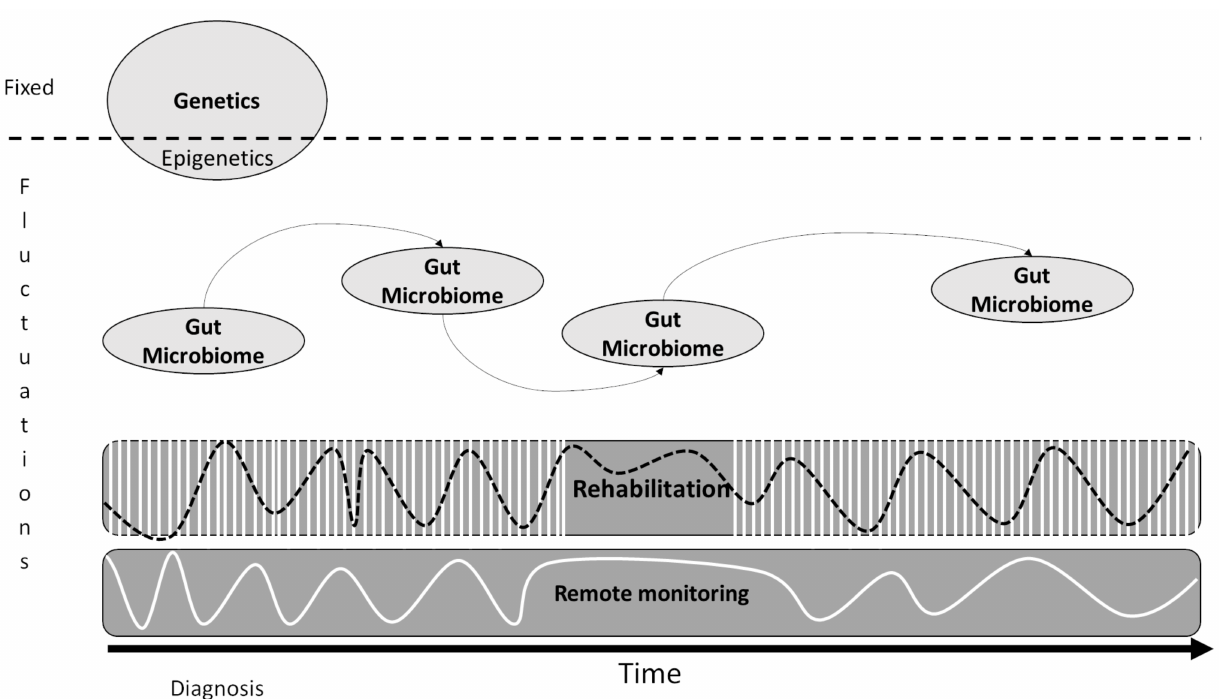
Figure 3. Schematic representation of the potential integration of rehabilomics data in the assessment and longitudinal follow-up of the patients over the course of the disease. Compared to other clinical measurements (e.g., genetics analysis performed once, brain imaging performed at intervals of several years, analysis of the microbiome should be performed more regularly to catch seasonal fluctuations [78]), functional data collected during the rehabilitation process and/or in the living environment can capture with more accuracy the fluctuations (e.g., changes in motor and/or cognitive functions [82]) of the patients during the rehabilitation sessions (indicated by the black sinusoidal line on the schema, vertical white lines indicated the rehabilitation sessions) and during activities of daily living (indicated by the white sinusoidal line on remote monitoring box), which is of particular importance for pwMS, since they can be done on a regular basis (i.e., rehabilitation) or continuous basis (i.e., remote